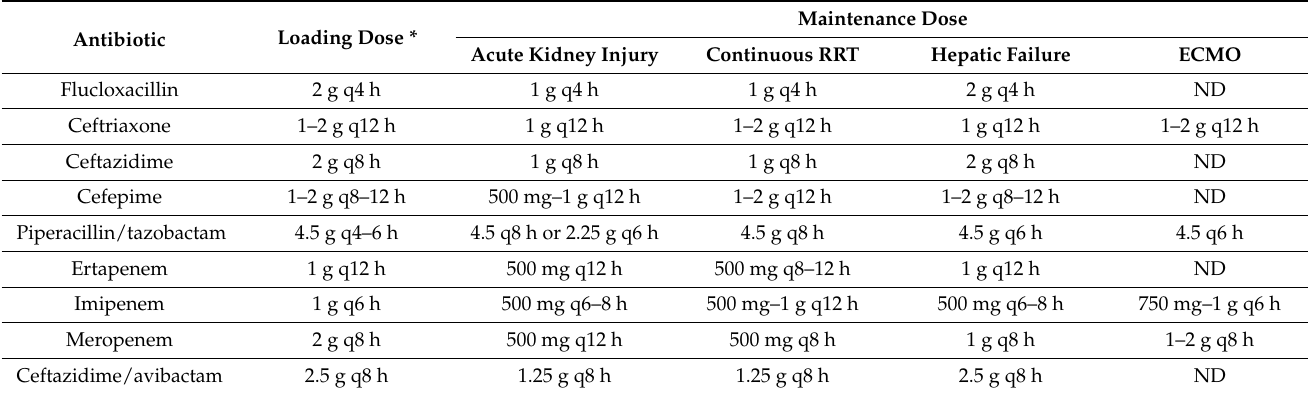
Table 1. Dose recommendations for β -lactams in critically ill patients with organ